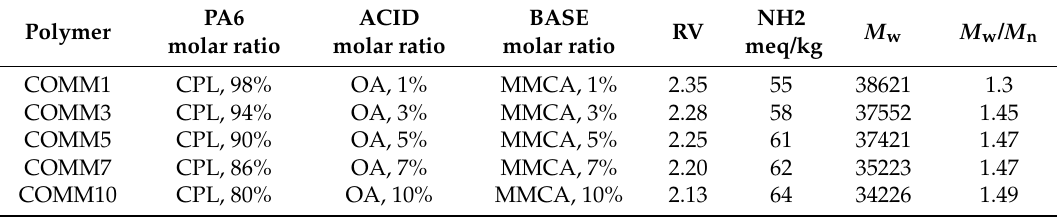
Table 4. Composition of PA6 containing dimer oleic acidand. 4,4'-Methylenebis (2- Composition of PA6 containing dimer oleic acidand. 4,4 (cid:48) -Methylenebis (2- methylcyclohexylamine). methylcyclohexylamine).